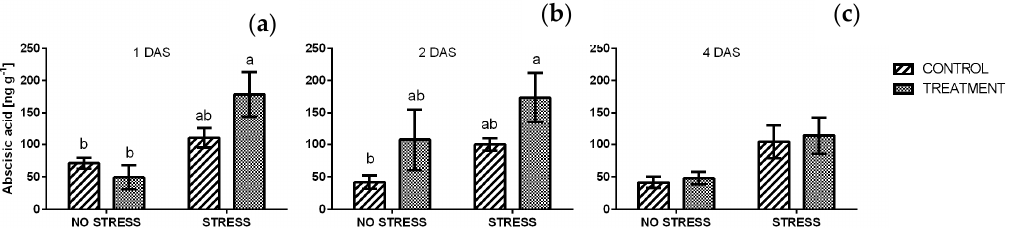
Figure 12. Abscisic acid concentration in rocket leaves treated with water (CONTROL) and with borage extract (TREATMENT) and subjected to salt stress (200 mM). Measures were taken one day ( a ), two days ( b ) and four days ( c ) of the stress. Values are means ± SE ( n = 4). Data were subjected to two-way ANOVA. Different letters, where present, represent significant differences ( p < 0.05).